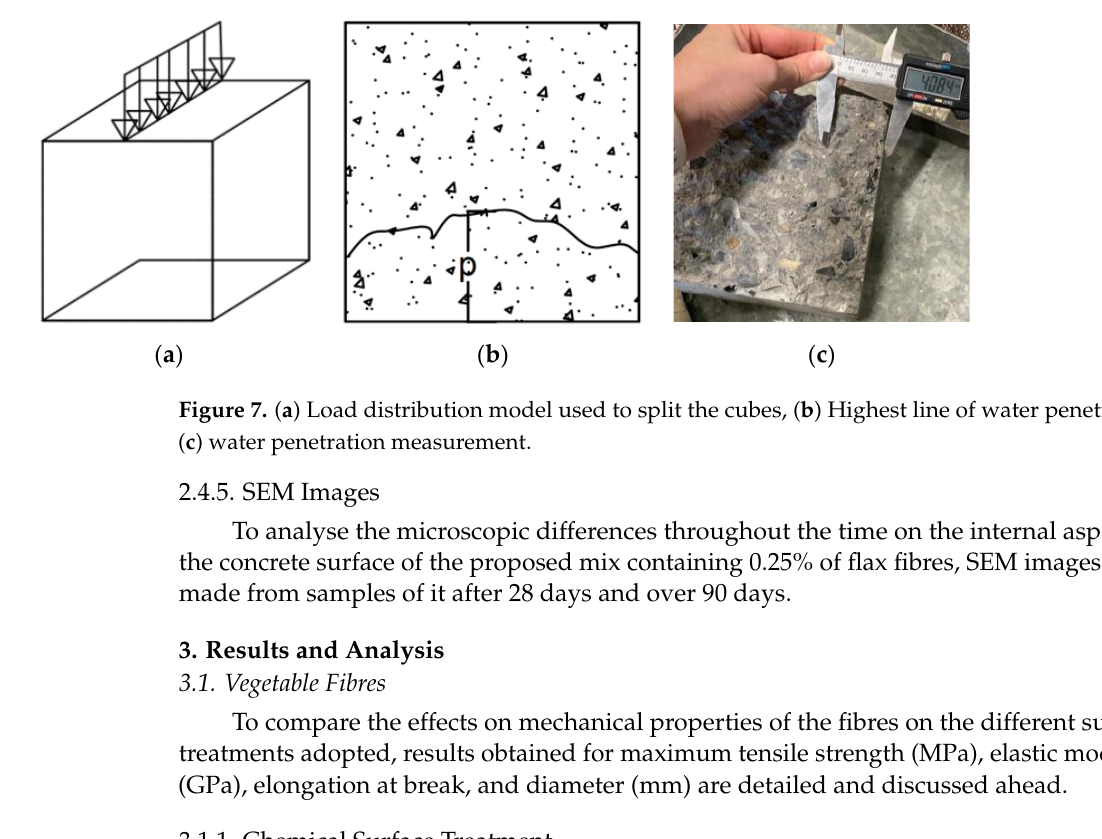
Figure 7. ( a ) Load distribution model used to split the cubes, ( b ) Highest line of water penetration ( c ) water penetration measurement.